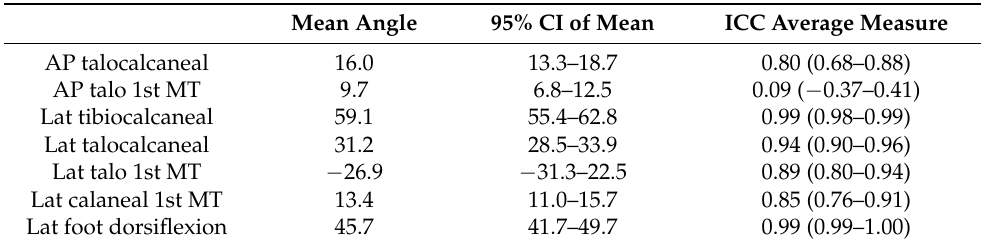
Table 2. Angles measured on radiograph and interrater